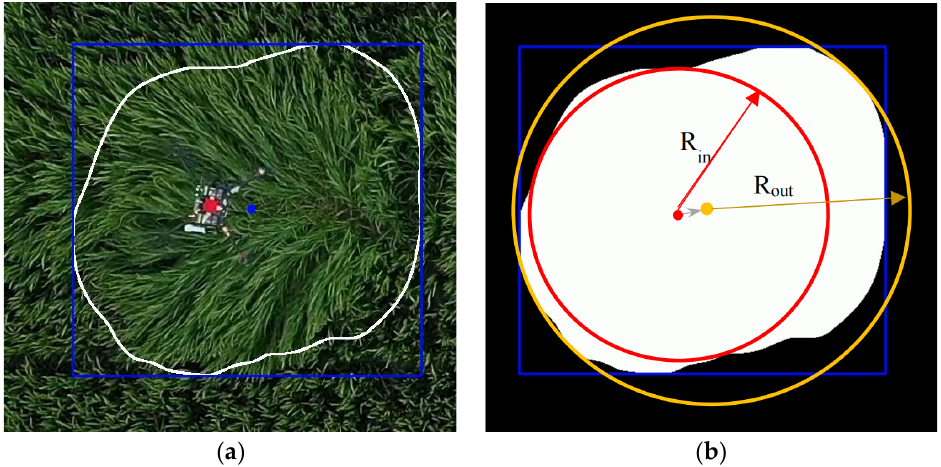
Figure 6. Inscribed and circumscribed circles of the wind-vortex profile. ( a ) Wind-vortex image. ( b ) Circumscribed circle and inscribed circle. Note: The minimum circumscribed circle and the maximum inscribed circle in ( b ) are obtained from ( a ) the wind-vortex profile. The orange and red circles represent the circumscribed circle and the inscribed circle, respectively, and the orange and red dots represent the circumscribed circle and the inscribed circle, respectively. In the center of the inscribed circle, the gray arrow represents the relative position of the two circles, that is, the convex direction of the wind vortex. Table 3. Data